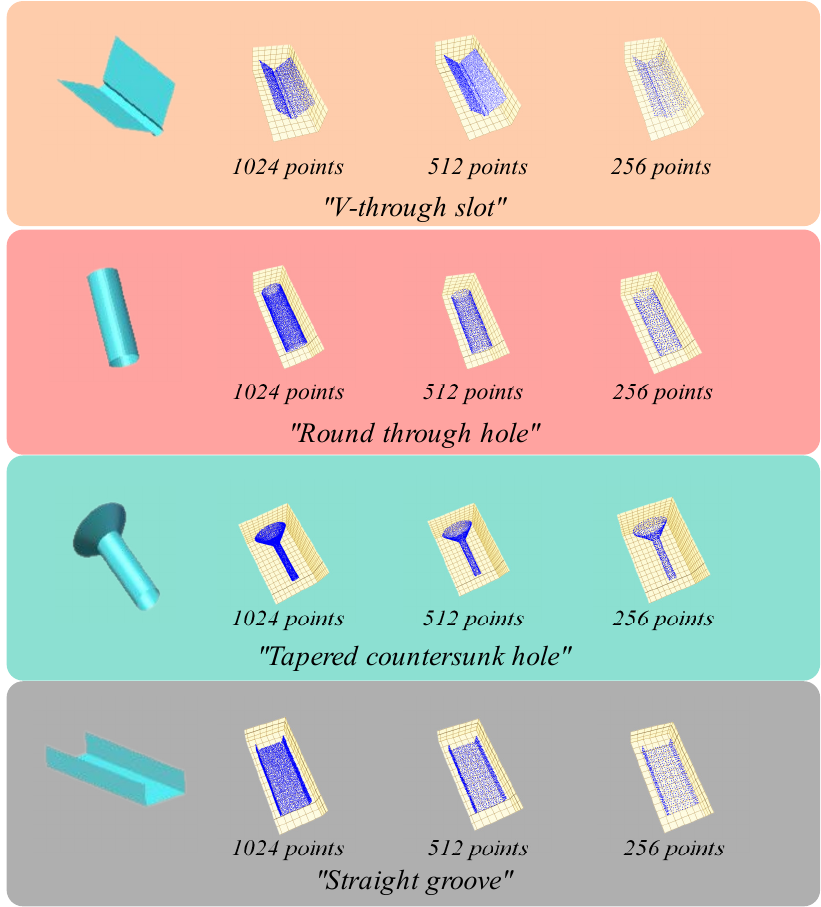
Figure 4. Some machining feature point cloud